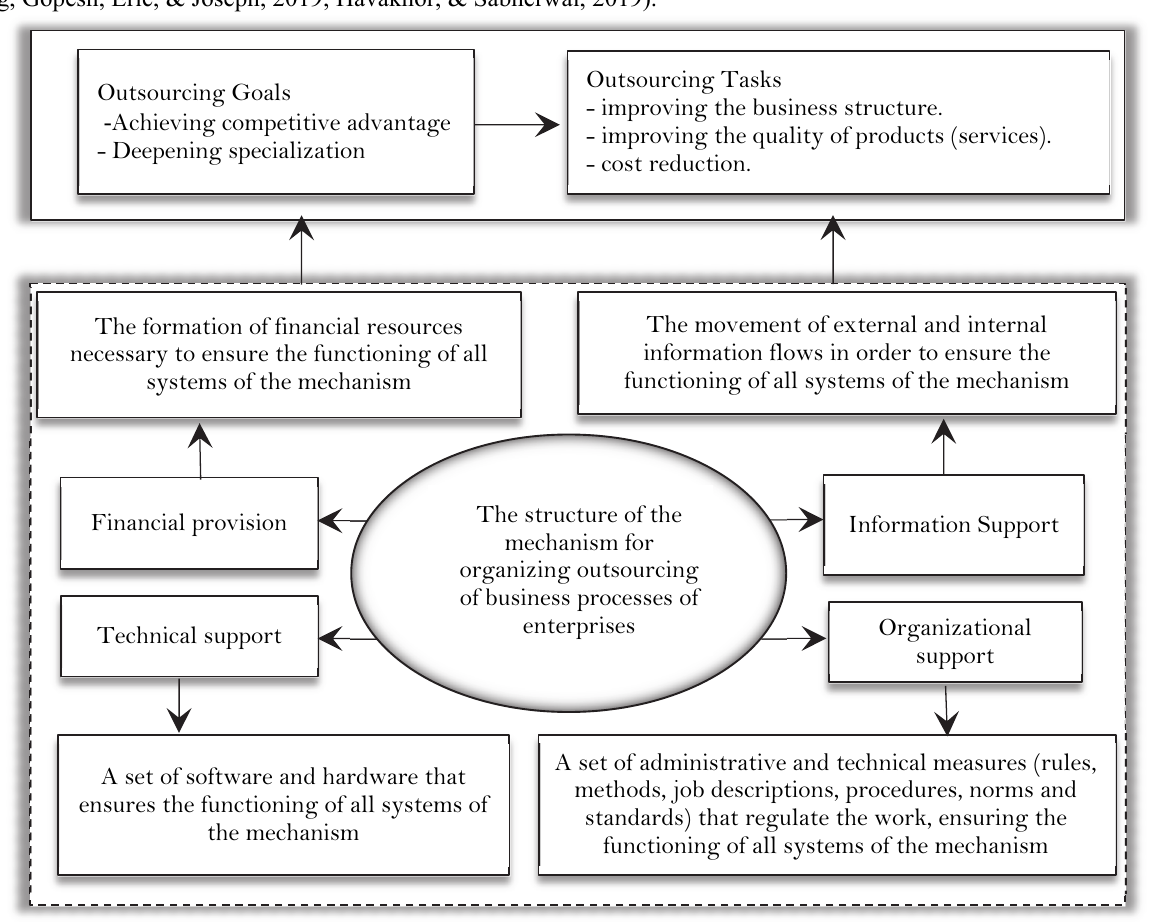
Fig. 1. Shows the structure of the outsourcing mechanism for corporate business operation (Alkarawy, 2018) Generally, the information support system consists of three main blocks: structural information, planning information, and an operational information unit. The introduction of an effective information system should coordinate the activities of all of its departments and employees on the basis of synchronization of production and management processes. The mechanism's